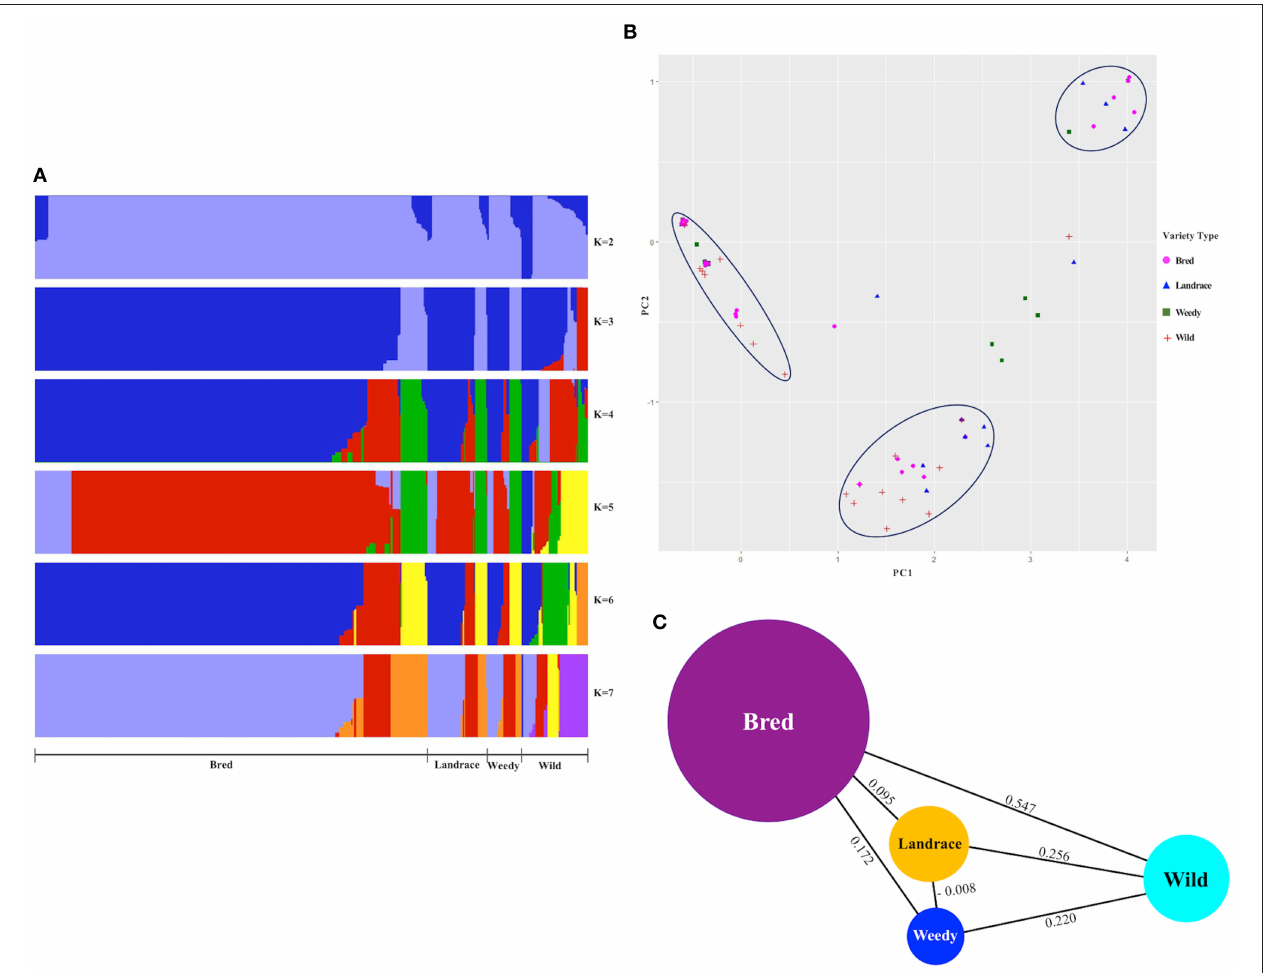
FIGURE 2 | Estimation of structure and population differentiation within the gene region of GBSSI ( Os06g0133000 ) in the Korean rice collection in terms of different varietal types (landrace, weedy, bred, and wild). (A) Population structure clustering of the GBSSI gene in 475 accessions of the Korean rice collection analyzed by increasing K -values from 2 to 7. For each K -value, different colors refer to different numbers of clustered populations. (B) Two-dimensional (2D) principal component analysis (PCA) of 475 accessions of the Korean rice collection. (C) Pairwise estimates of genetic differentiation ( F ST values) of the GBSSI gene among different variety types of the 475 accessions of the Korean rice